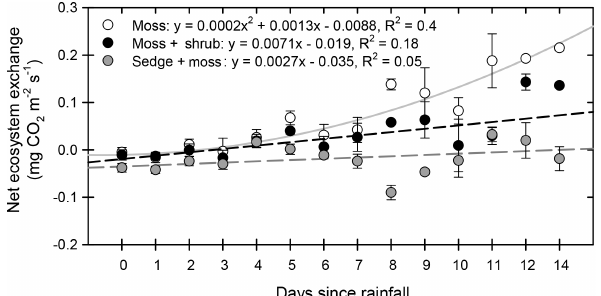
Figure 7. Relationships between NEE and the number of consecu- tive dry days since rainfall for each vegetation community. Negative NEE represents CO 2 uptake. Error bars represent the standard devi- ation of the mean. The relationships for the moss and moss + shrub communities are significant at the p < 0 . 001 level ; the relationship for the sedge + moss communities is significant at the p = 0 . 045